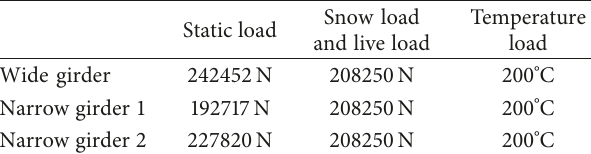
Table 6: The load information of column.